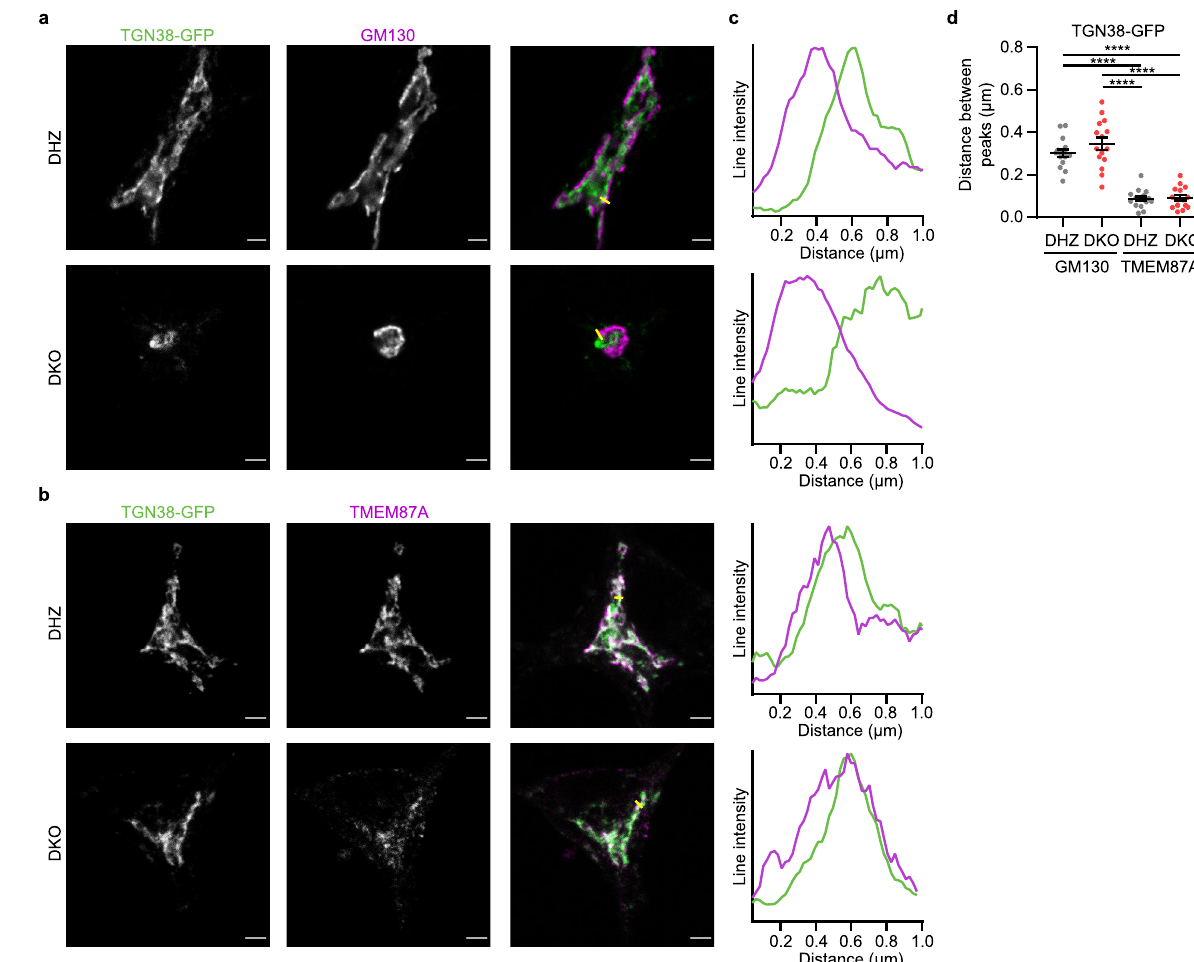
Figure 5. TGN38-GFP can reach the TGN compartment in Vti1a/b DKO neurons. ( a ) Representative examples of neurons overexpressing TGN38-GFP immunostained for GM130. (Brightness and contrast have been adjusted for visualization). ( b ) Representative examples of neurons overexpressing TGN38-GFP immunostained for TMEM87A. (Brightness and contrast have been adjusted for visualization). ( c ) Intensity profiles of TGN38- GFP and GM130/TMEM87A. Location of lines is represented as a yellow line in merged images. Intensities were normalized and smoothed before plotting. ( d ) The distance between intensity peaks of TGN38-GFP and GM130 is larger than the distance between peaks of TGN38-GFP and TMEM87A in both Vti1a/b DHZ and DKO neurons, measured by line scans through the Golgi (DHZ GM130: n = 15; DKO GM130: n = 15; DHZ TMEM87A: n = 15; DKO TMEM87A: n = 15). One way ANOVA with Tukey’s multiple comparisons test: DHZ GM130 vs DHZ TMEM87A, DHZ GM130 vs DKO TMEM87A, DKO GM130 vs DHZ TMEM87A and DKO Table 1. Scale bar is 2